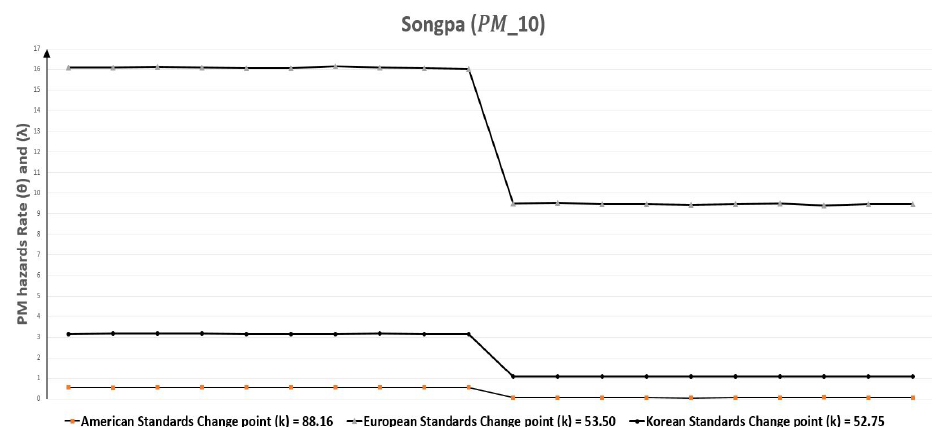
Figure 23. Songpa (Seoul, South Korea) monthly polluted days before and after the change point due to PM 10